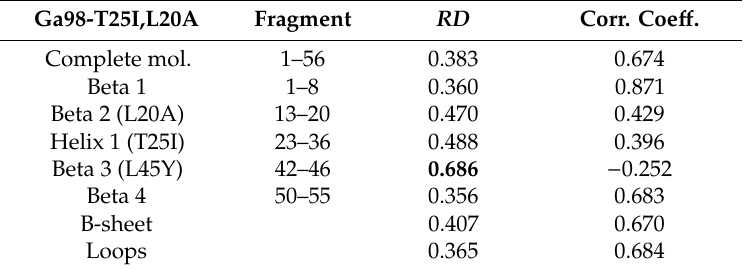
Table 5. List of parameters characterizing the status of the whole Ga98-T25I, L20A protein and highlighted sections representing a specific secondary structure. Bold— RD status di ff erent from idealized (discordant